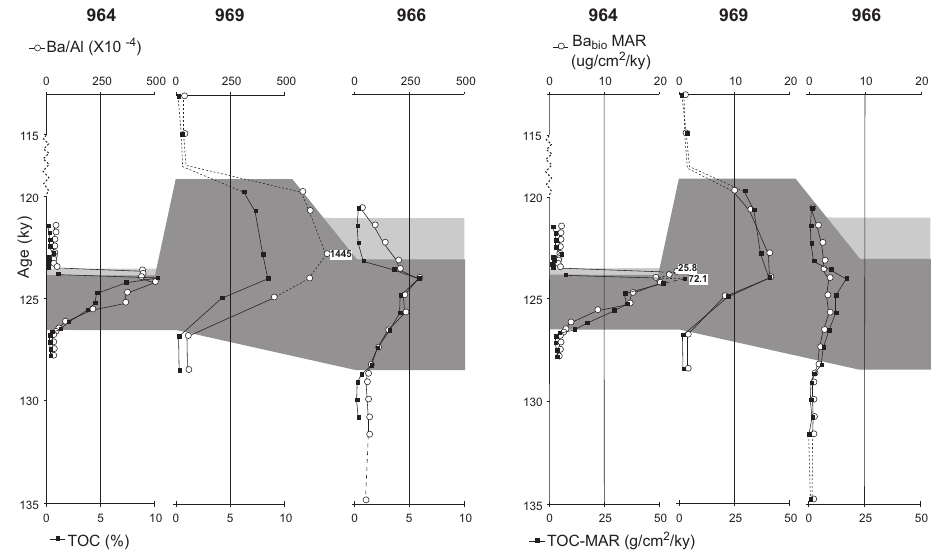
Fig. 3. Comparison of TOC and Ba/Al vs. TOC-MAR and Ba bio MAR for S5 on three studied sites. Dark shade corresponds to visible sapropel layer. Light shade represents oxydized sapropel. Maximum values off-scale are numerically indicated on the graph.